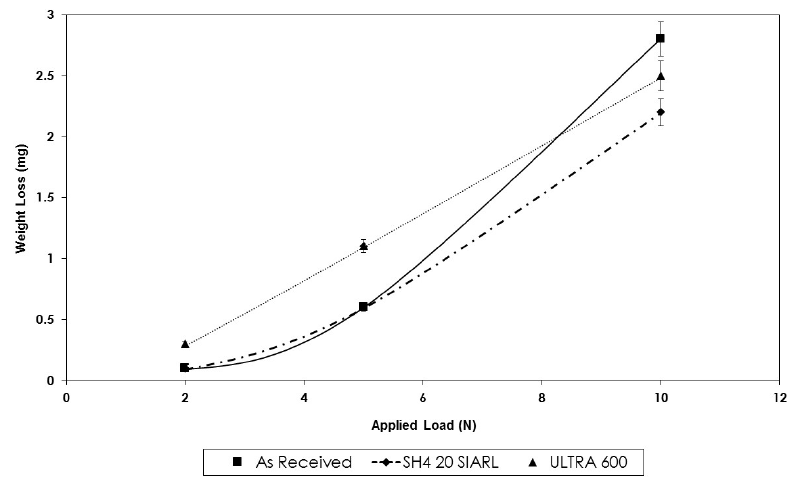
Figure 5. Effect of applied load on the weight loss of multilayered polymer-based coatings on glass and bare soda-lime glass.